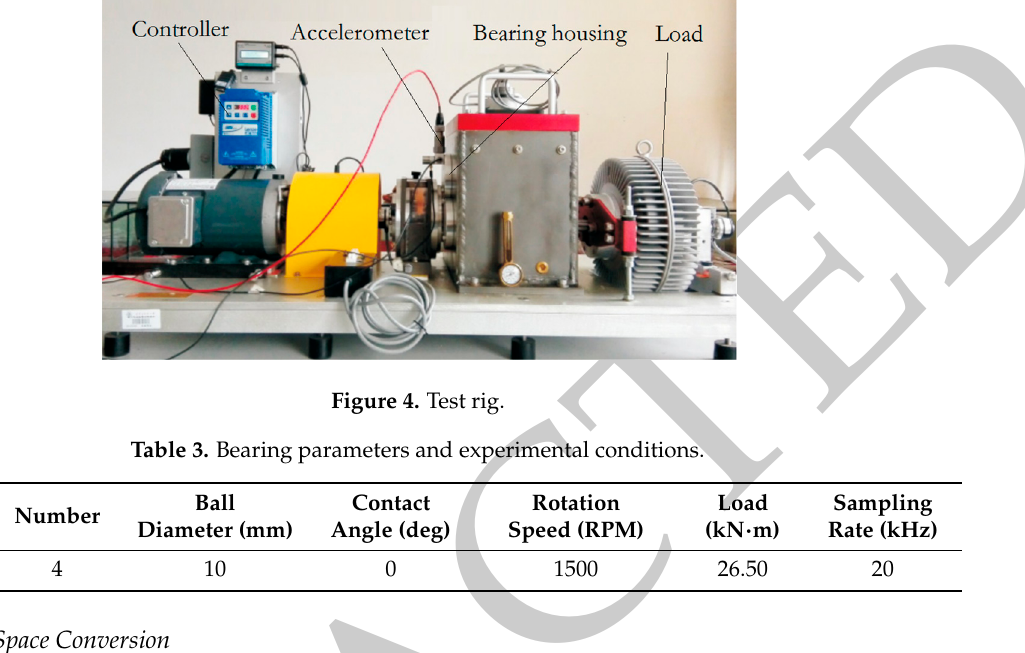
Figure 4. Test rig. Table 3. Bearing parameters and experimental conditions.